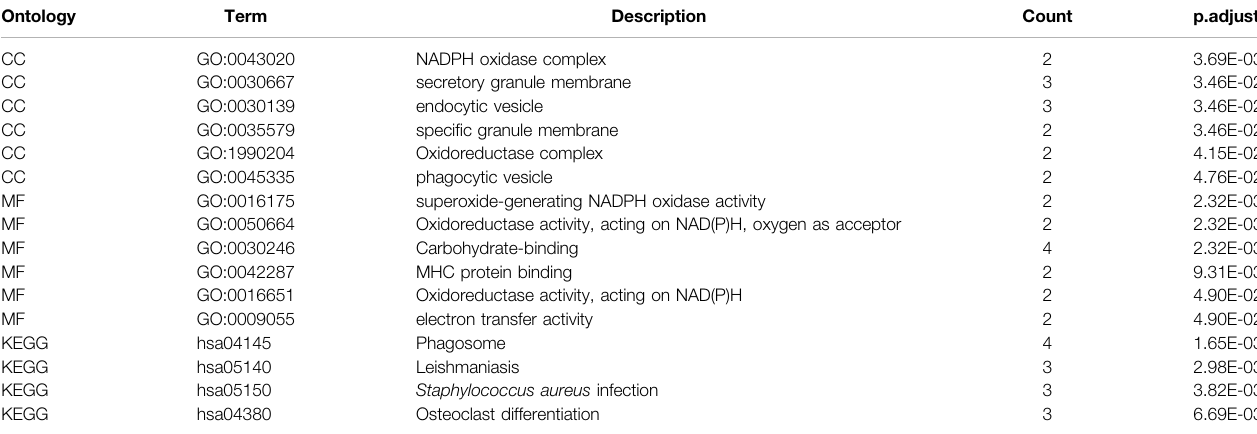
TABLE 3 | GO-Cellular Components, GO-Molecular Function, and KEGG pathway enrichment analysis of DEGs in GC samples.